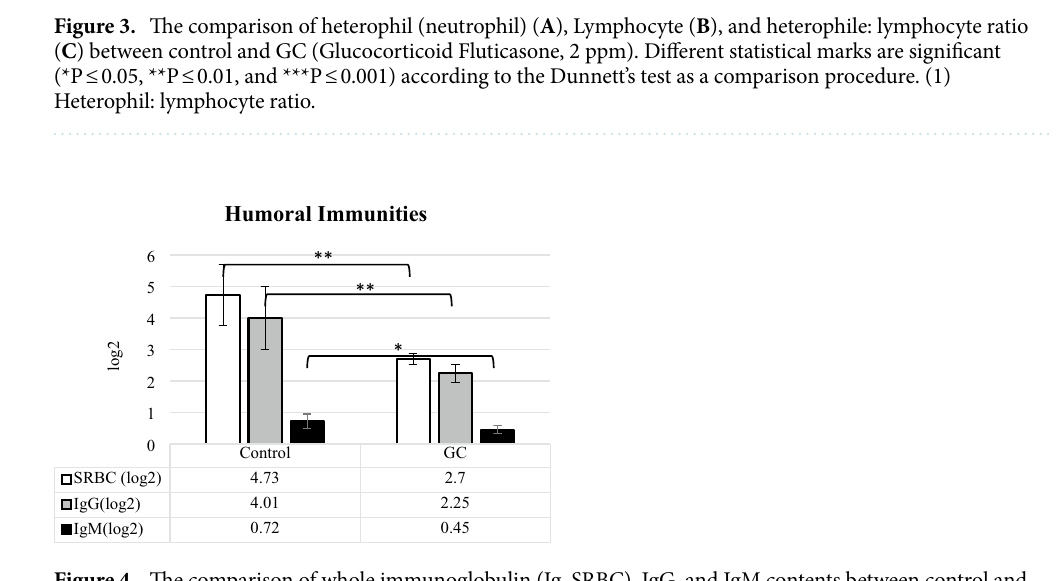
Figure 4. The comparison of whole immunoglobulin (Ig, SRBC), IgG, and IgM contents between control and GC (Glucocorticoid Fluticasone, 2 ppm). Different statistical marks are significant (*P ≤ 0.05, **P ≤ 0.01, and ***P ≤ 0.001) according to the Dunnett’s test as a comparison